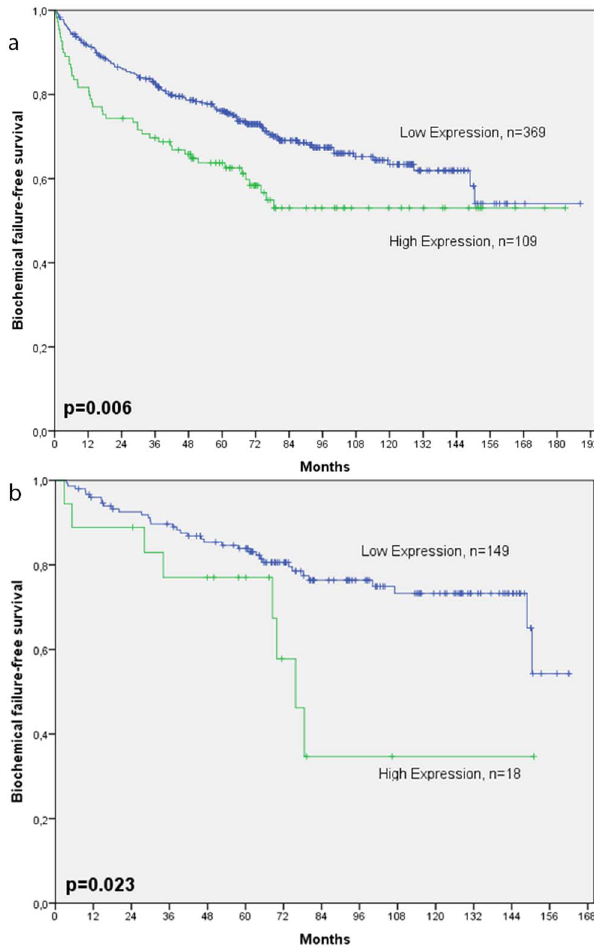
Figure 3. Disease-specific survival according to biochemical failure and high stromal expression of miR-21 in: a) Total cohort. b) Patients with Gleason score 6.